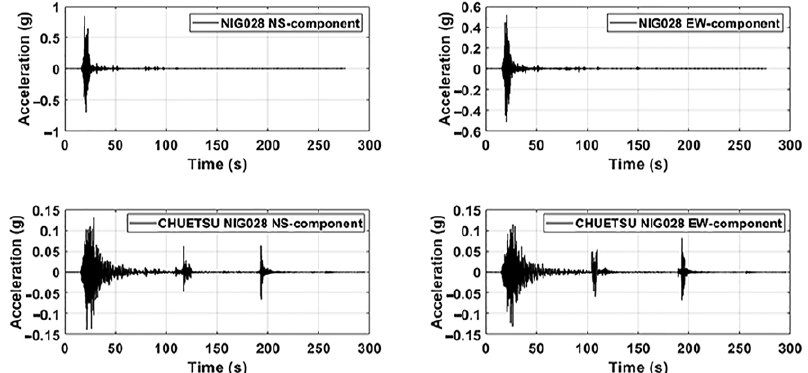
Figure 5. Ground motions inputted into the developed building model